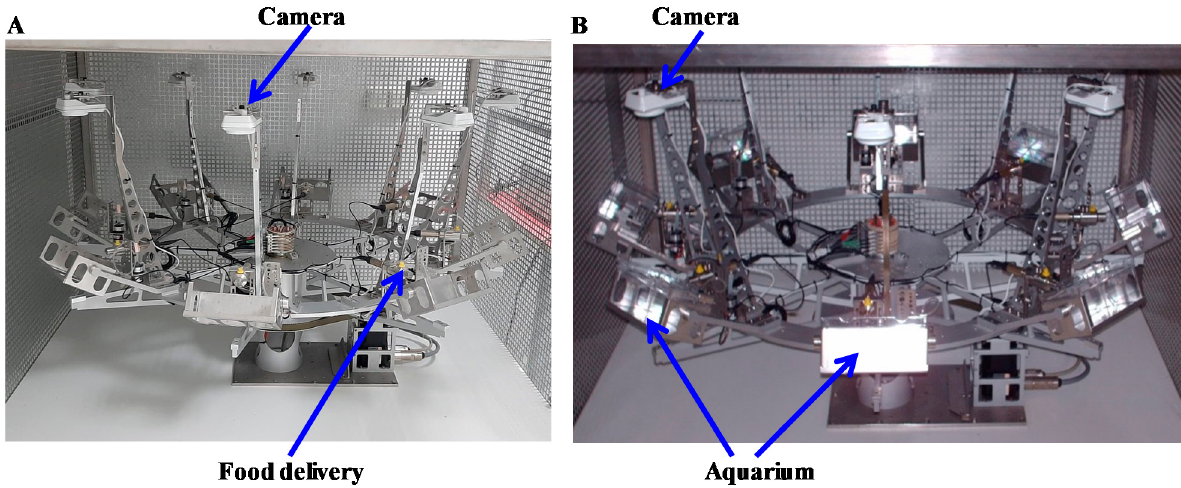
Figure 2. Rotor allowing the centrifugation of eight 0.5-L aquariums. ( A ) Centrifuge without aquariums in gondolas. ( B ) Centrifuge with the aquariums.